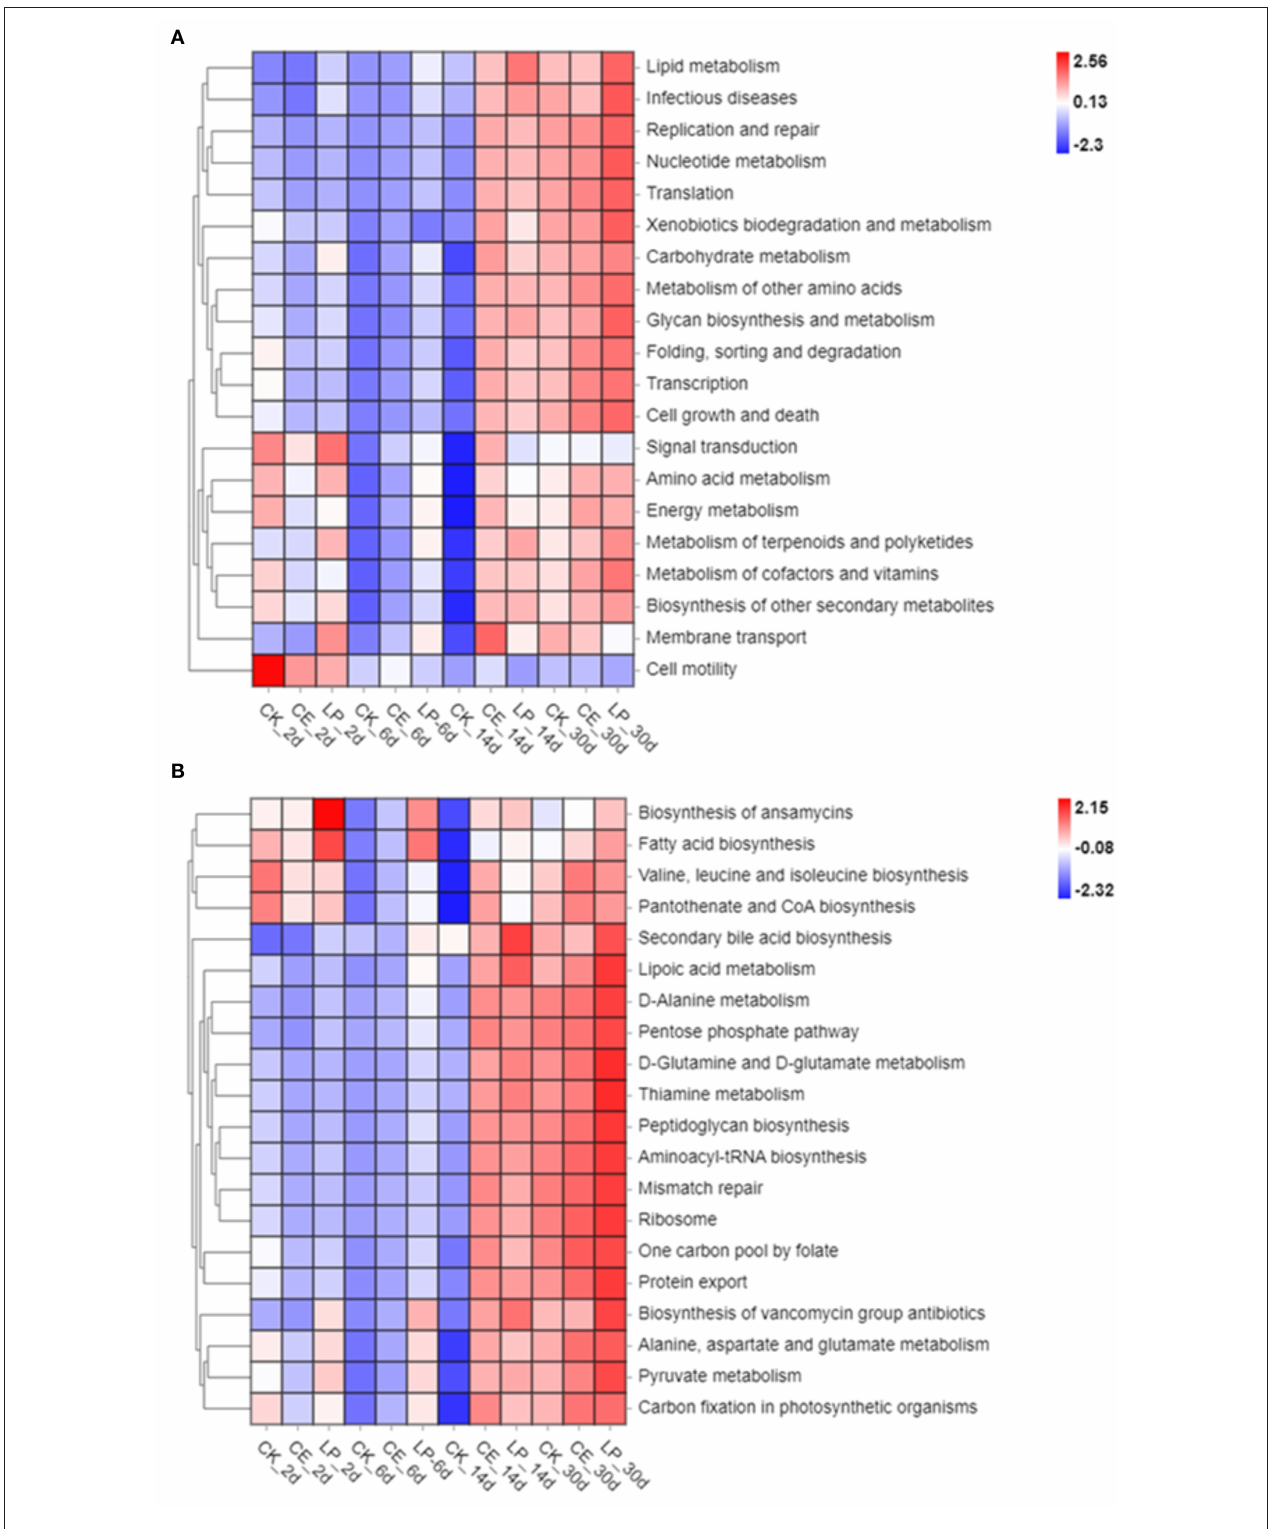
FIGURE 4 | Heatmap of the top 20 predicted functions (A) and pathways (B) of the bacterial communities analyzed via Tax4Fun for cassia alata silage (CK, control; CE, cellulase; LP, Lactiplantibacillus plantarum , after 2, 6, 14, and 30 days of ensiling, respectively).